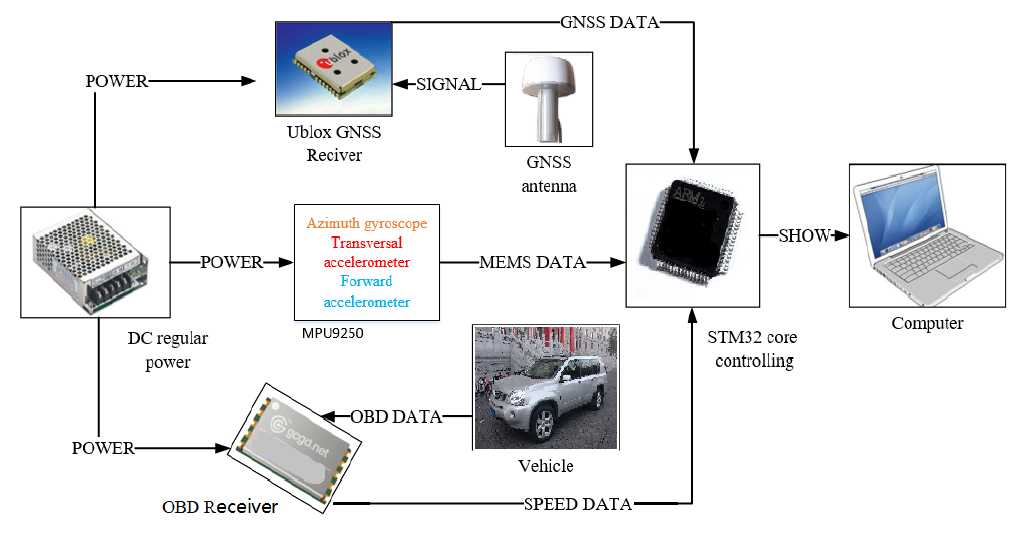
Figure 2. Experimental equipment structure